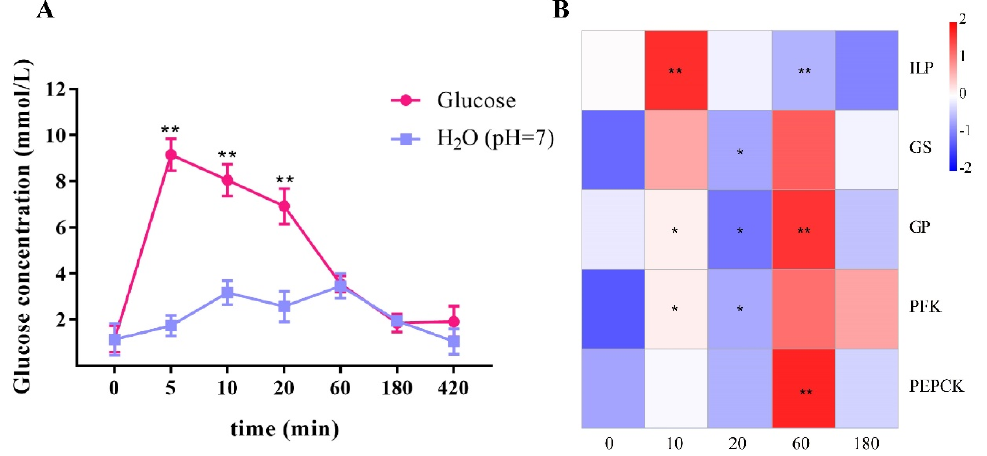
Figure 2. Effects of glucose injection on hemolymph glucose and the expressions of LvILP and glucose metabolism genes. ( A ) The variation curve of hemolymph glucose concentration of L. vannamei within 420 min of glucose injection; error bars indicate the mean ± SD of three replicate samples. ( B ) Heatmap of the relative expression levels of LvILP , GS , GP , PFK , and PEPCK genes at different time points relative to the control group. The redder color indicates a higher expression level, and the bluer indicates a lower expression level. The numbers at the bottom represent the treatment time (min). The expression levels of the genes were detected by RT-qPCR, and 18 S rRNA was used as an internal reference. Statistical significances are shown as * p < 0.05 and ** p < 0.01.